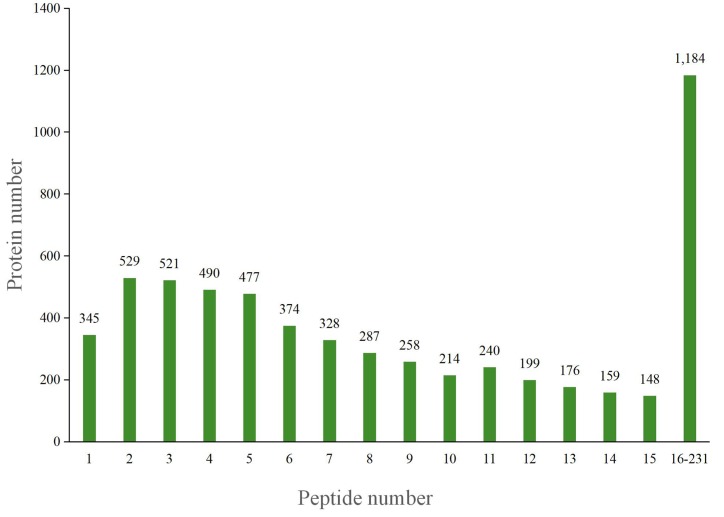
Quantitative distribution of peptides in identified proteins.